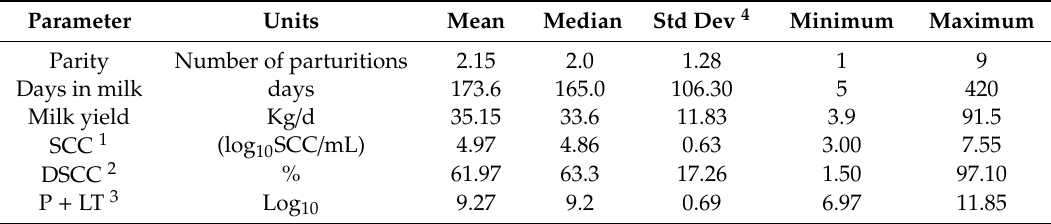
Table 1. Description of the main characteristics of the dataset analyzed (17,939 individual milk samples from 2425